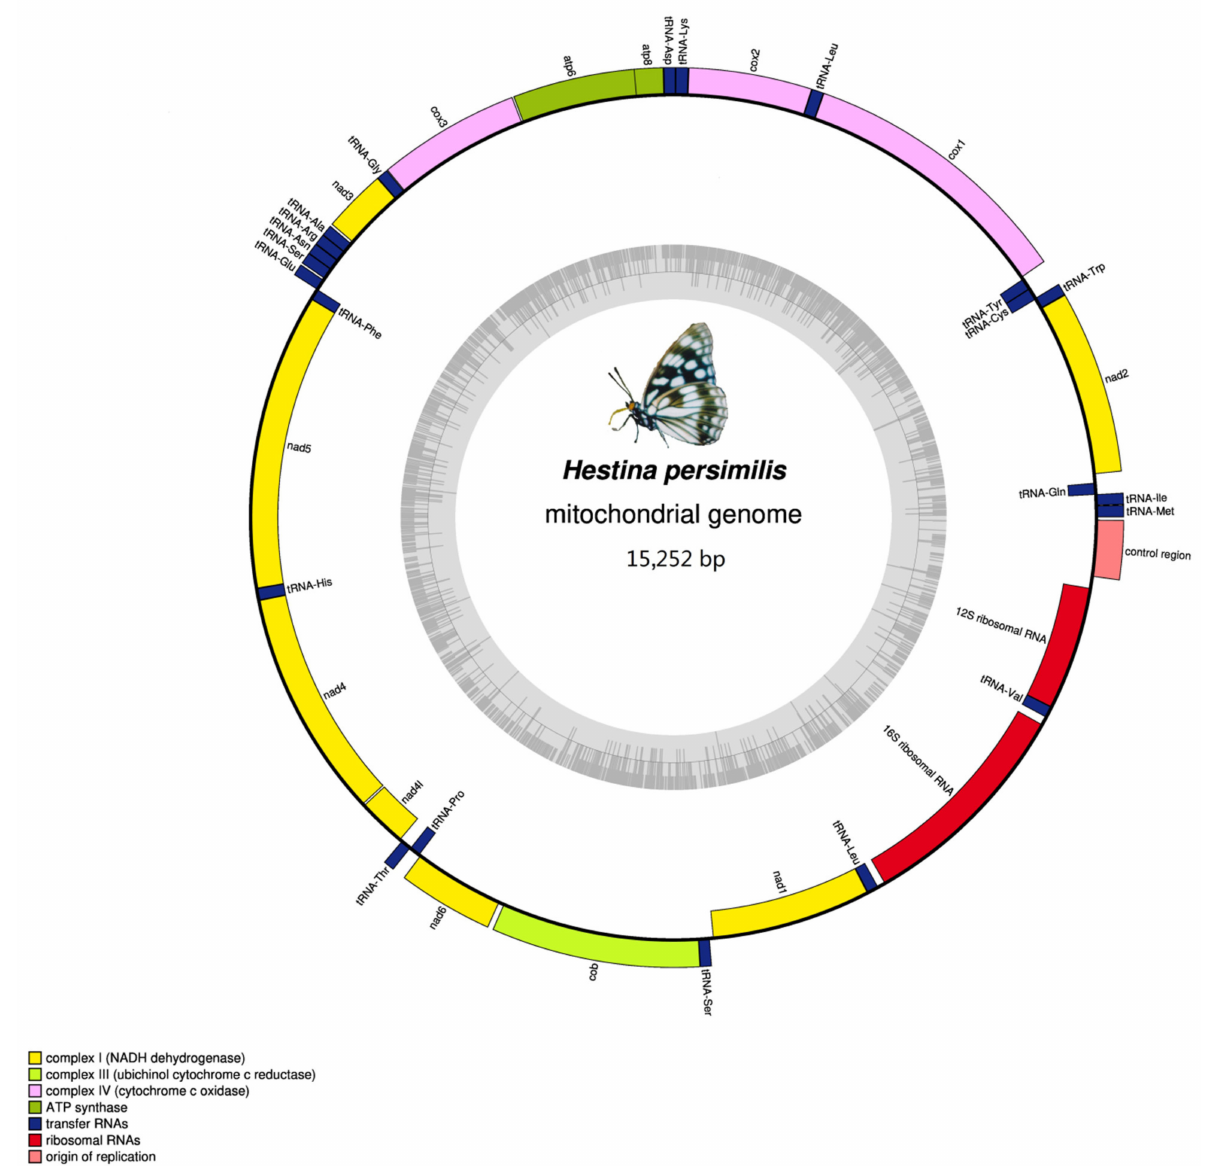
Figure 1. Linear map of the mitogenome of Hestina persimilis . The J-strand is located on the linear map, and the N-strand is under the linear